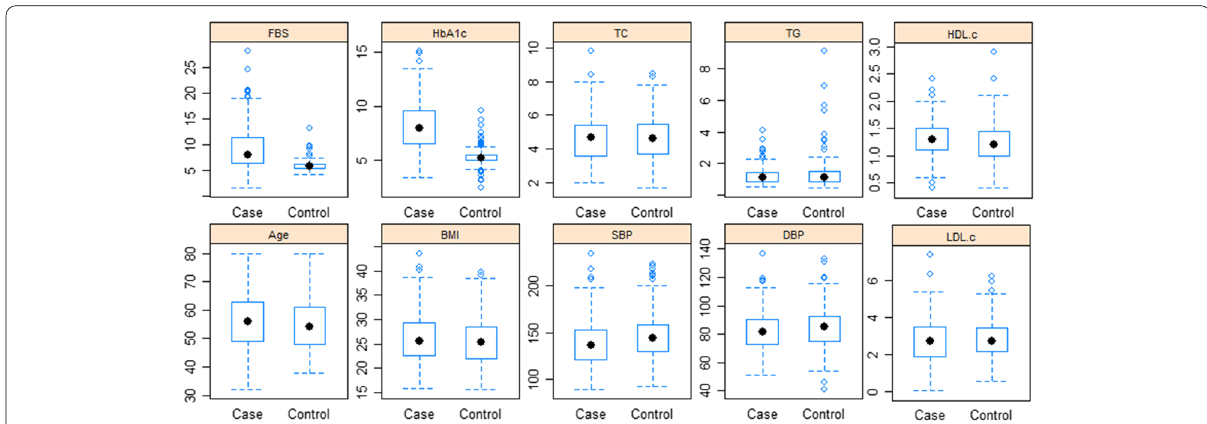
Fig. 4 Distribution of study features across T2DM and non‑T2DM subjects. Note that HbA1c is glycated haemoglobin , TC is Total Cholesterol ; BMI is body mass index; FBS is Fasting blood sugar ; DBP is Diastolic Blood Pressure; TG is Triglycerides ; SBP is Systolic Blood Pressure ; HDL‑c is high‑density lipoprotein cholesterol; LDL-c is density lipoprotein cholesterol